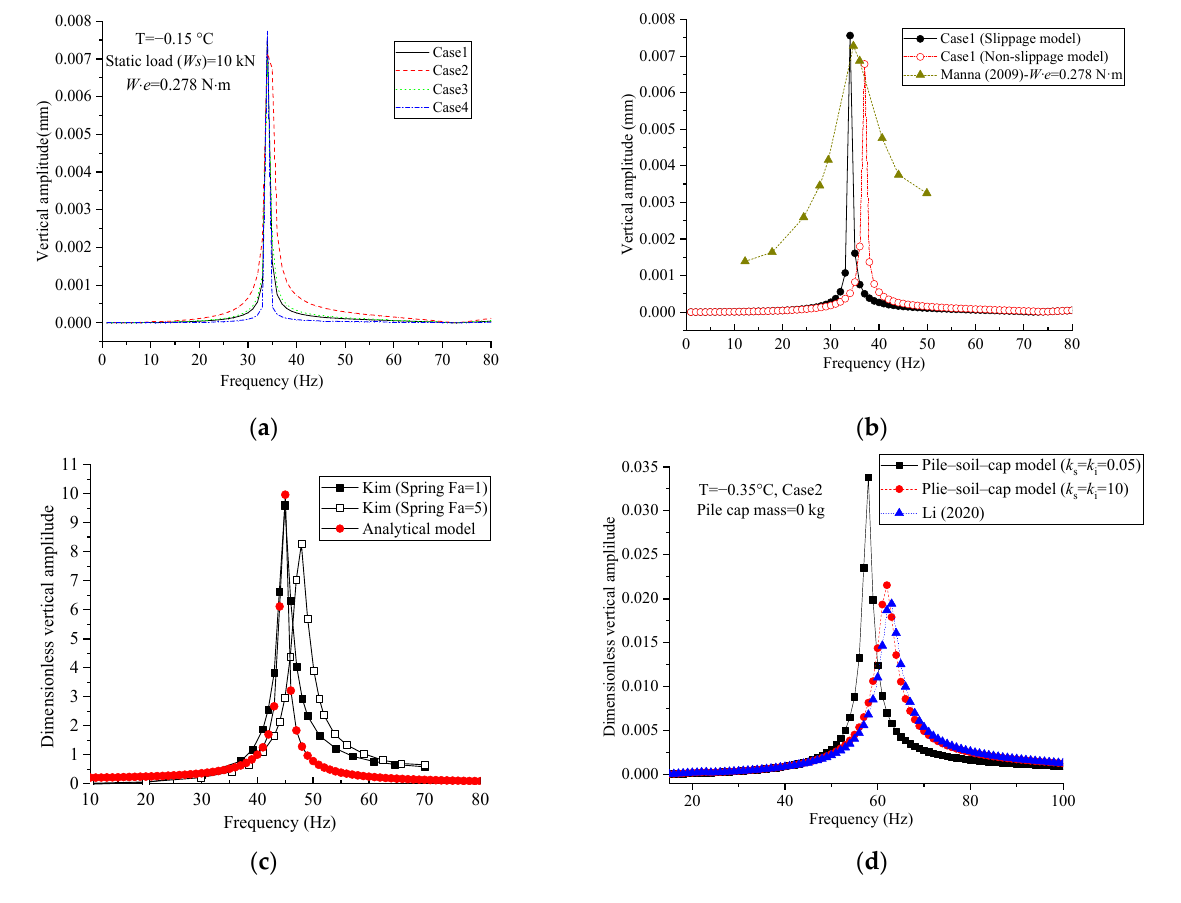
Figure 2. Verification of the simplified layered model with the existing results (Reprinted/adapted with permission from Refs. [61,63,70]. 2020; 2004; 2009, Elsevier; Korean Society of Civil Engineers; Taylor & Francis). ( a ) Four cases of degradation validation; ( b ) comparison with Manna experi- mental data for validation; ( c ) comparison with Kim numerical simulation data for validation and ( d ) comparison with Li’s theoretical model.